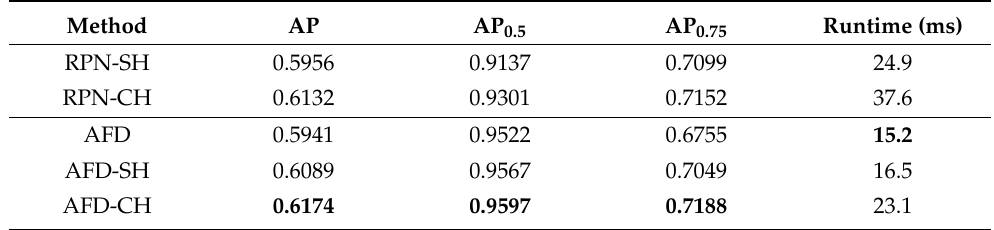
Table 2. Performance of anchor-based RPN and anchor-free detector (AFD) in two-stage detectors on the SSDD dataset.